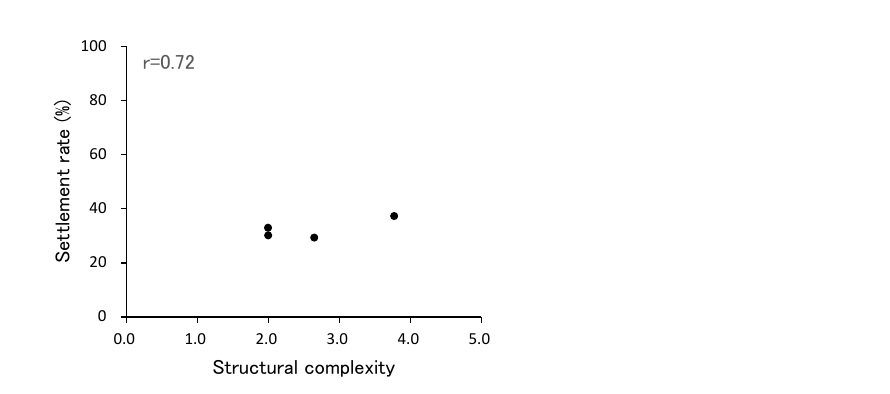
7 Table 4. Mean settlement rate and standard deviation (%) of the substrata in the first sampling. Year